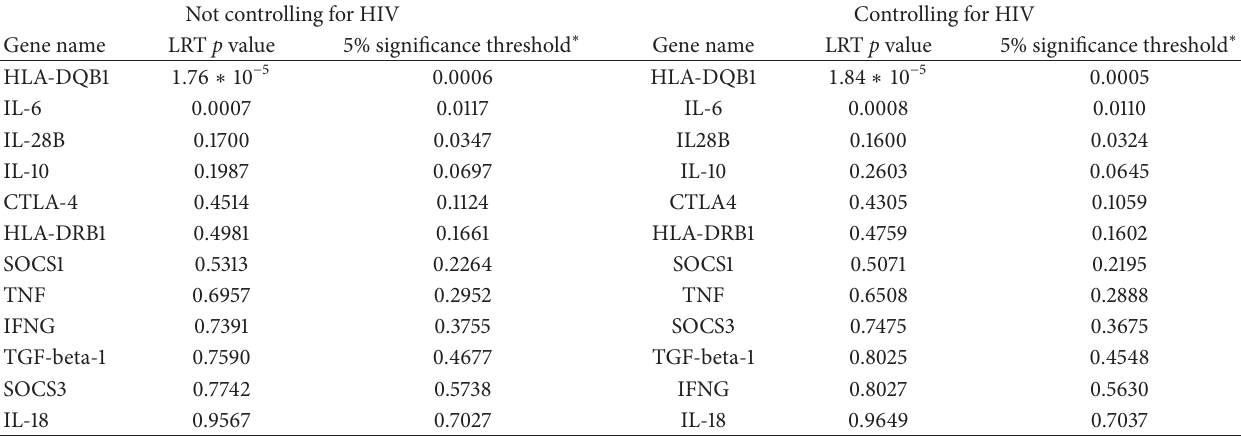
Table 3: Likelihood ratio test (LRT) results comparing full models (consisting of all SNPs for the gene) and null models after controlling for HIV infection.